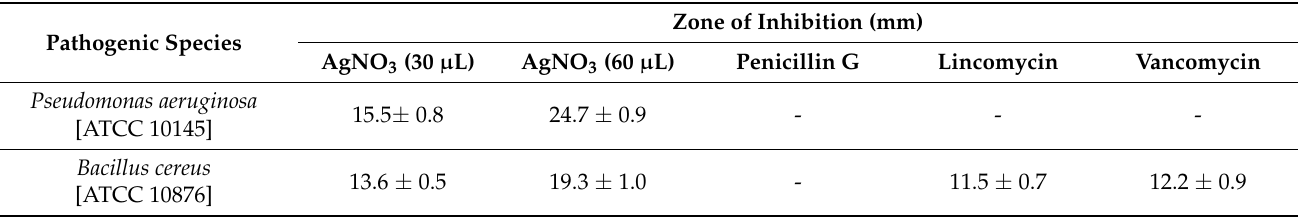
Table 2. Antibacterial efficacy of P. nicotinovorans MAHUQ-43-mediated synthesized AgNPs and some commercial antibi- otics against P. aeruginosa and B. cereus